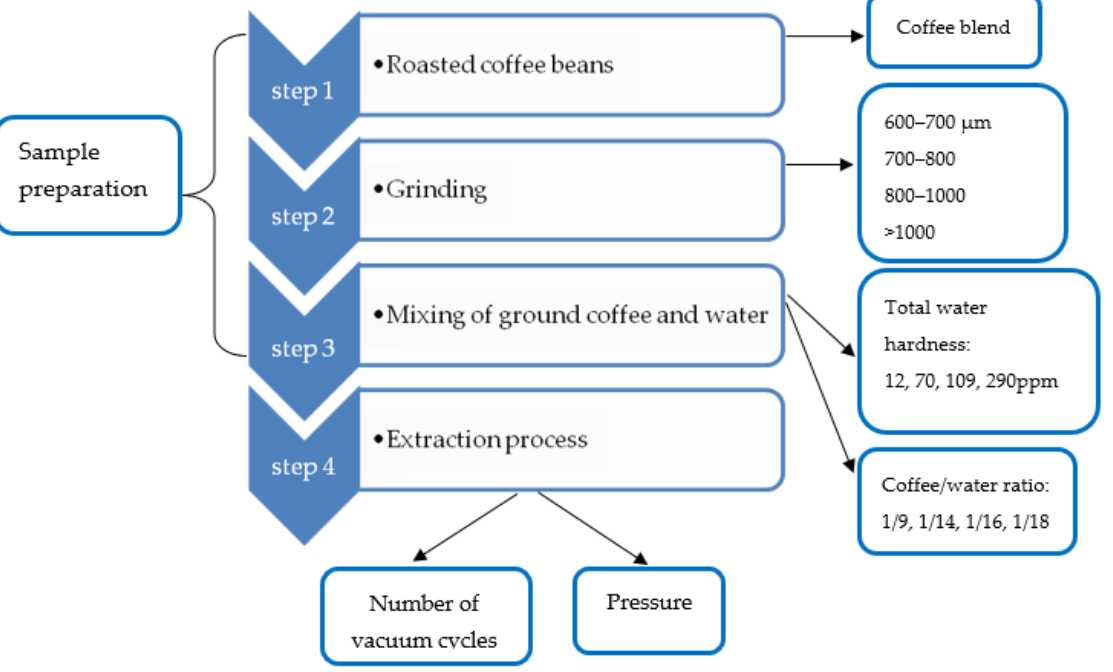
Figure 6. Process Flow Diagram of experimental procedure and the variables to be